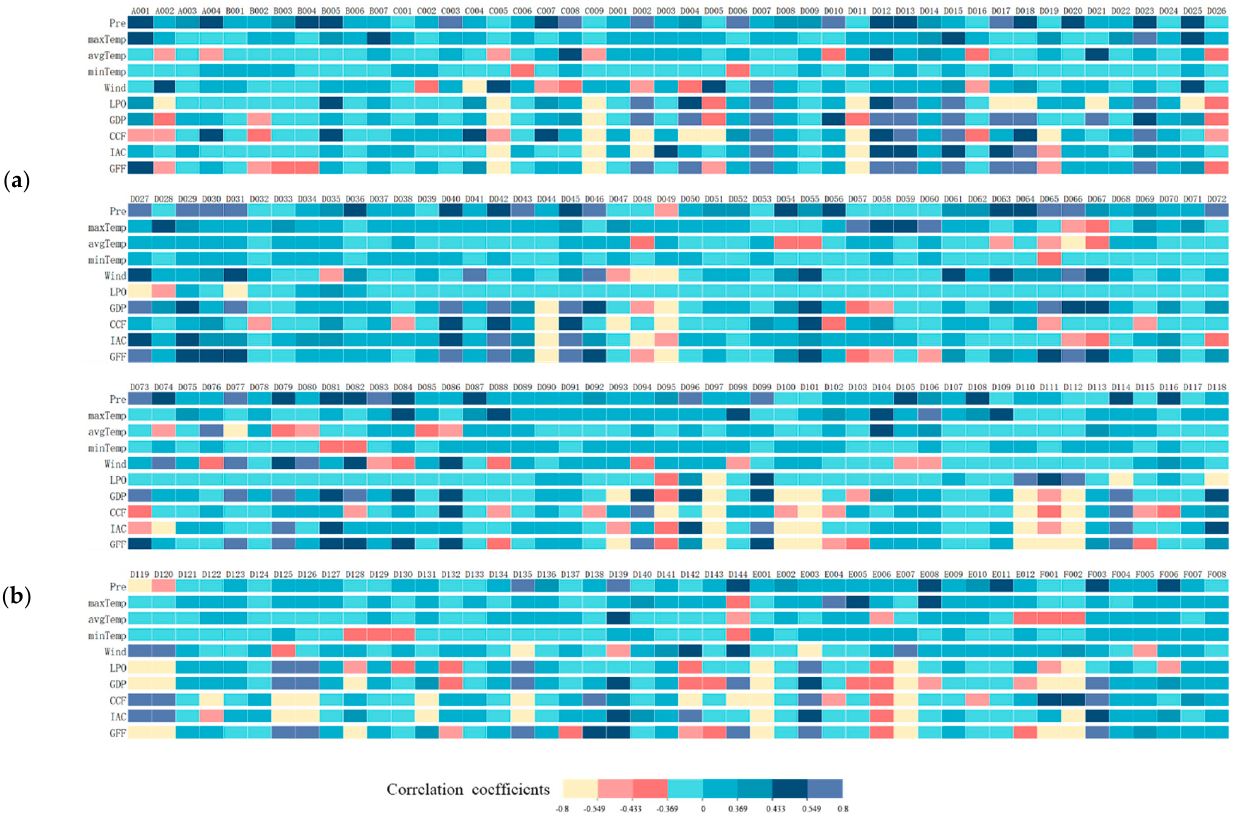
Figure 10. Correlation coefficients between annual lake area and their potential driving factors, from 2000 to 2020. The factors represented by rows from top to bottom are precipitation, maximum temperature, average temperature, and minimum temperature, wind, LPO, GDP, CCF, IAC, and GFF. ( a ) Lake A001–D072 and ( b ) lake D073–F008. Note: when |r| > 0.369, the correlation is marginally significant at p < 0.1; when |r| > 0.433, the correlation is significant at p < 0.05; and when |r| > 0.549, the correlation is significant at p < 0.01. When r > 0, it indicates a positive correlation; and when r < 0, it represents a negative